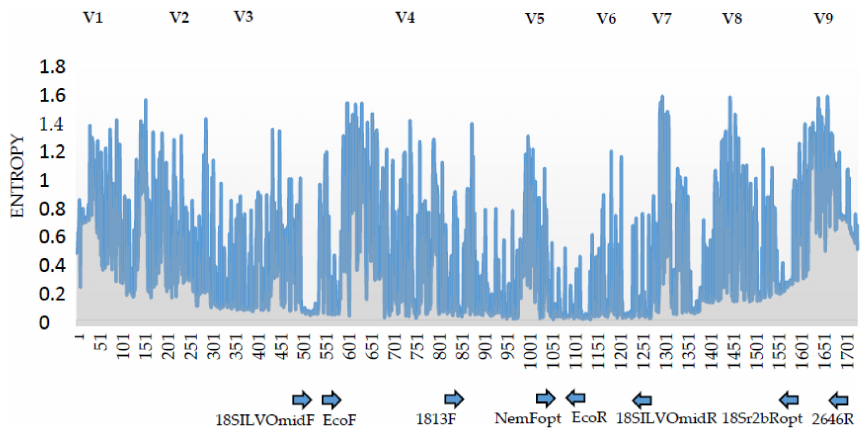
Figure 1. Shannon entropy values of all positions (bp) in the alignment derived from the nematode sequences from SILVA 128 along the 18S rRNA gene of Caenorhabditis elegans (AY268117) with positions of the DNA-(meta)barcoding primers. More nucleotide variable positions in the sequence are represented by a higher entropy value, a more conserved position by a lower entropy value. A region composed of a string of nucleotide positions with consistently low entropy values is most suited for primer design for DNA-metabarcoding. The variable regions V1-V9 and the positions of the primers used during this study are indicated. The arrows reveal the direction of the